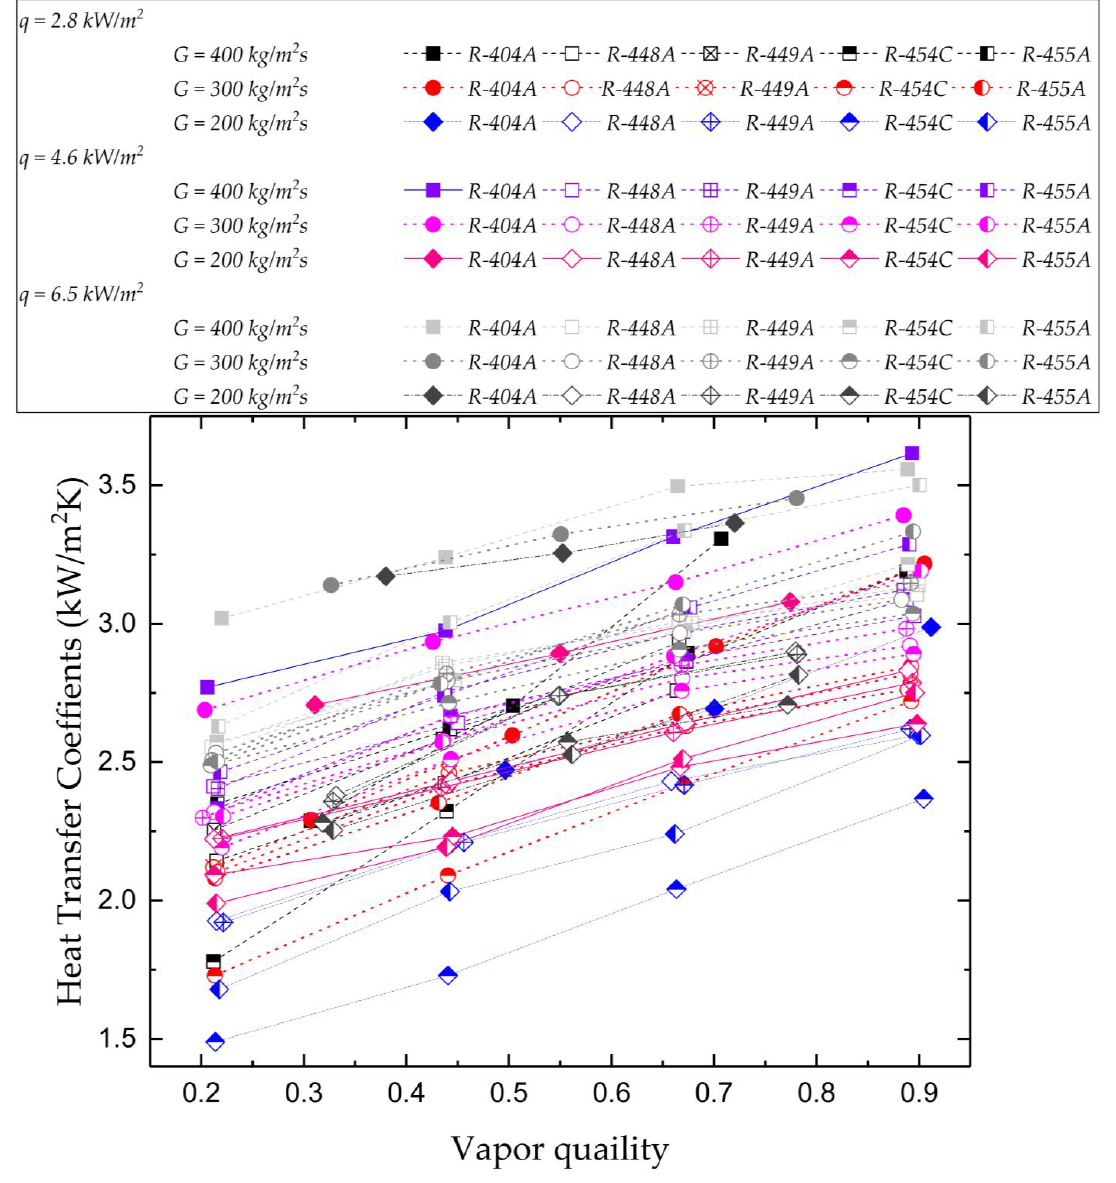
Figure 11. Evaporation HTCs of the R-404A and alternative refrigerants depicted as a function of mass flux [59]. Table 3. Inside the tube, specifications, dimensions, and experimental conditions from the literature.